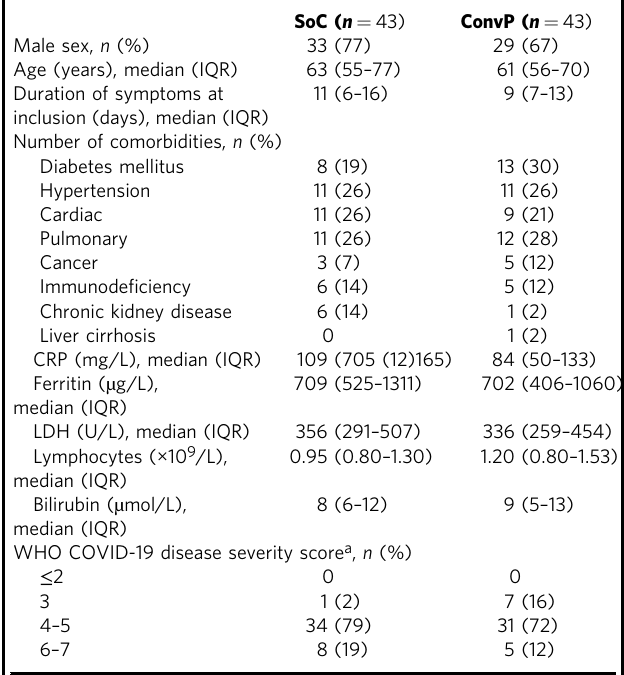
Table 1 Baseline characteristics of COVID-19